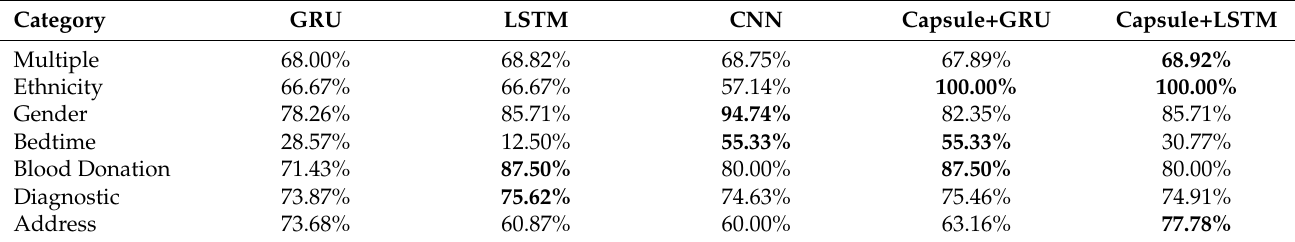
Table 6. Performance of different models in different